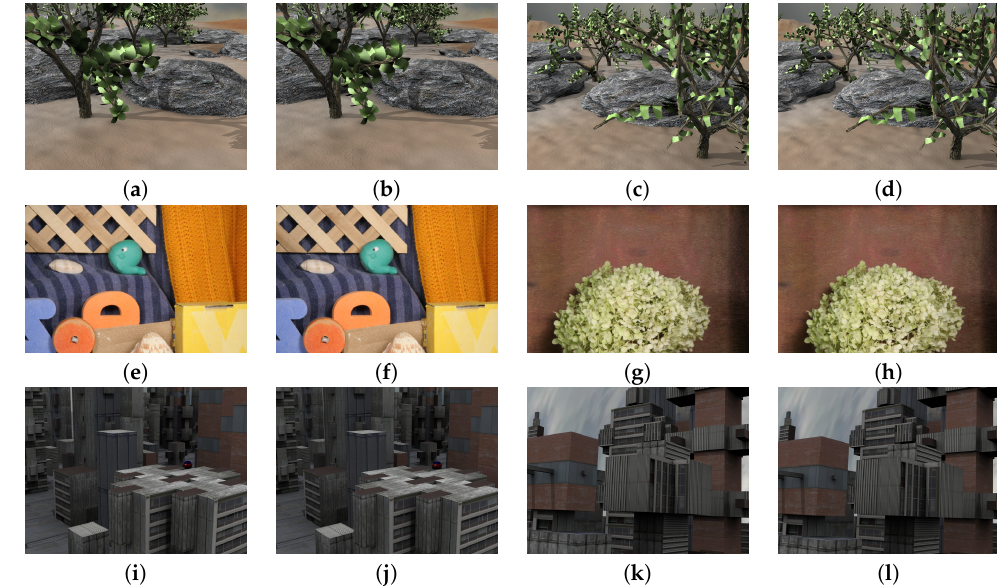
Figure 7. Images of the Middlebury database containing small displacements. ( a ) and ( b ) frame10 and frame11 of sequence Grove2, respectively. ( c ) and ( d ) frame10 and frame11 of sequence Grove3, respectively. ( e ) and ( f ) frame10 and frame11 of sequence RubberWhale, respectively. ( g ) and ( h ) frame10 and frame11 of sequence Hydrangea, respectively. ( i ) and ( j ) frame10 and frame11 of sequence Urban2, respectively and finally ( k ) and ( l ) of sequence Urban2,